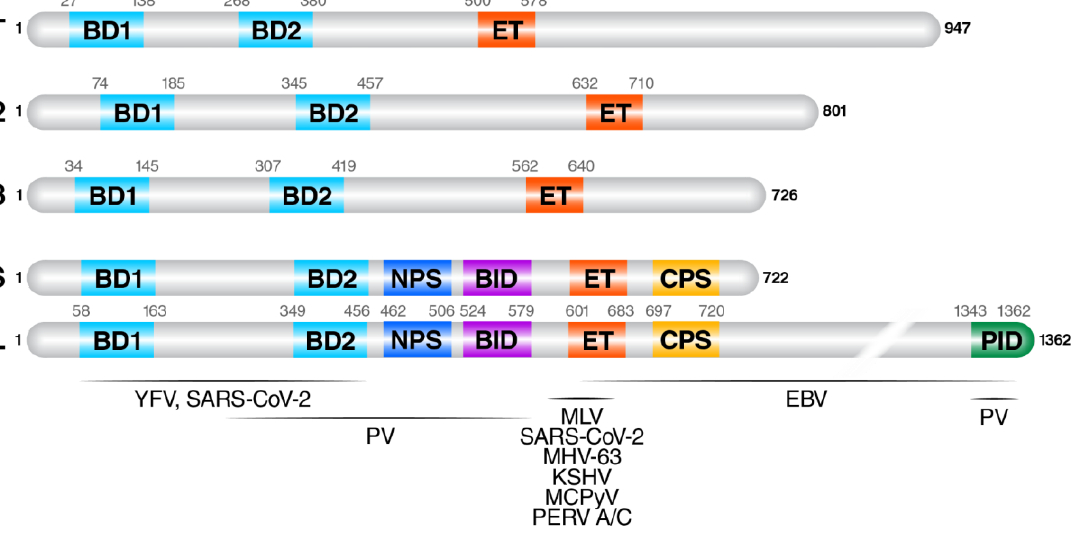
Figure 1. BET protein family members. BRDT, BRD2, BRD3, and BRD4 are the four mammalian members of this family. The main functional domains and their amino acid positions are indicated: BD1 (bromodomain 1), BD2 (bromodomain 2), ET (extraterminal domain), PID (P-TEFb interacting domain), BID (basic residue-enriched domain), NPS (N-terminal phosphorylation site), and CPS (C-terminal phosphorylation site). Horizontal lines span the regions of BRD4 that directly interact with the viruses described in this review; note however that other BET proteins can also interact with viruses. See Table 1 for more information.